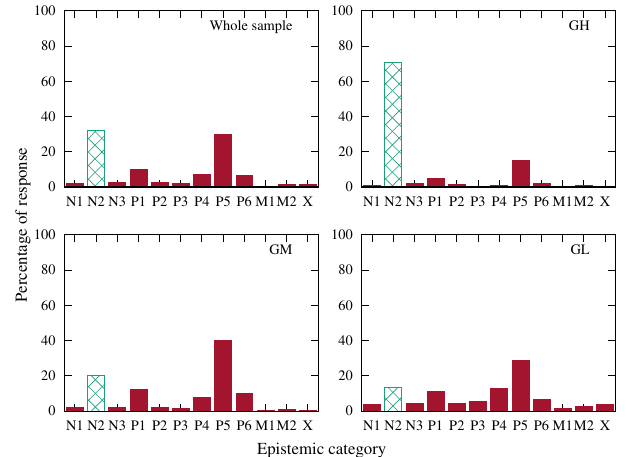
FIG. 5. Aggregate distribution of responses to all propositions (S1, S10, S28) corresponding to epistemic category N2. Format of the figure is the same as in Fig. 4.